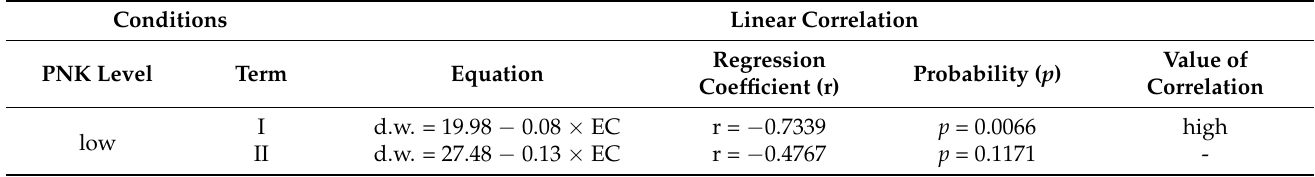
Table 12. The linear correlation between EC ( µ g · dm − 3 ) in water and dry weight of Hydrocharis morsus-ranae (g) in the three tested growing